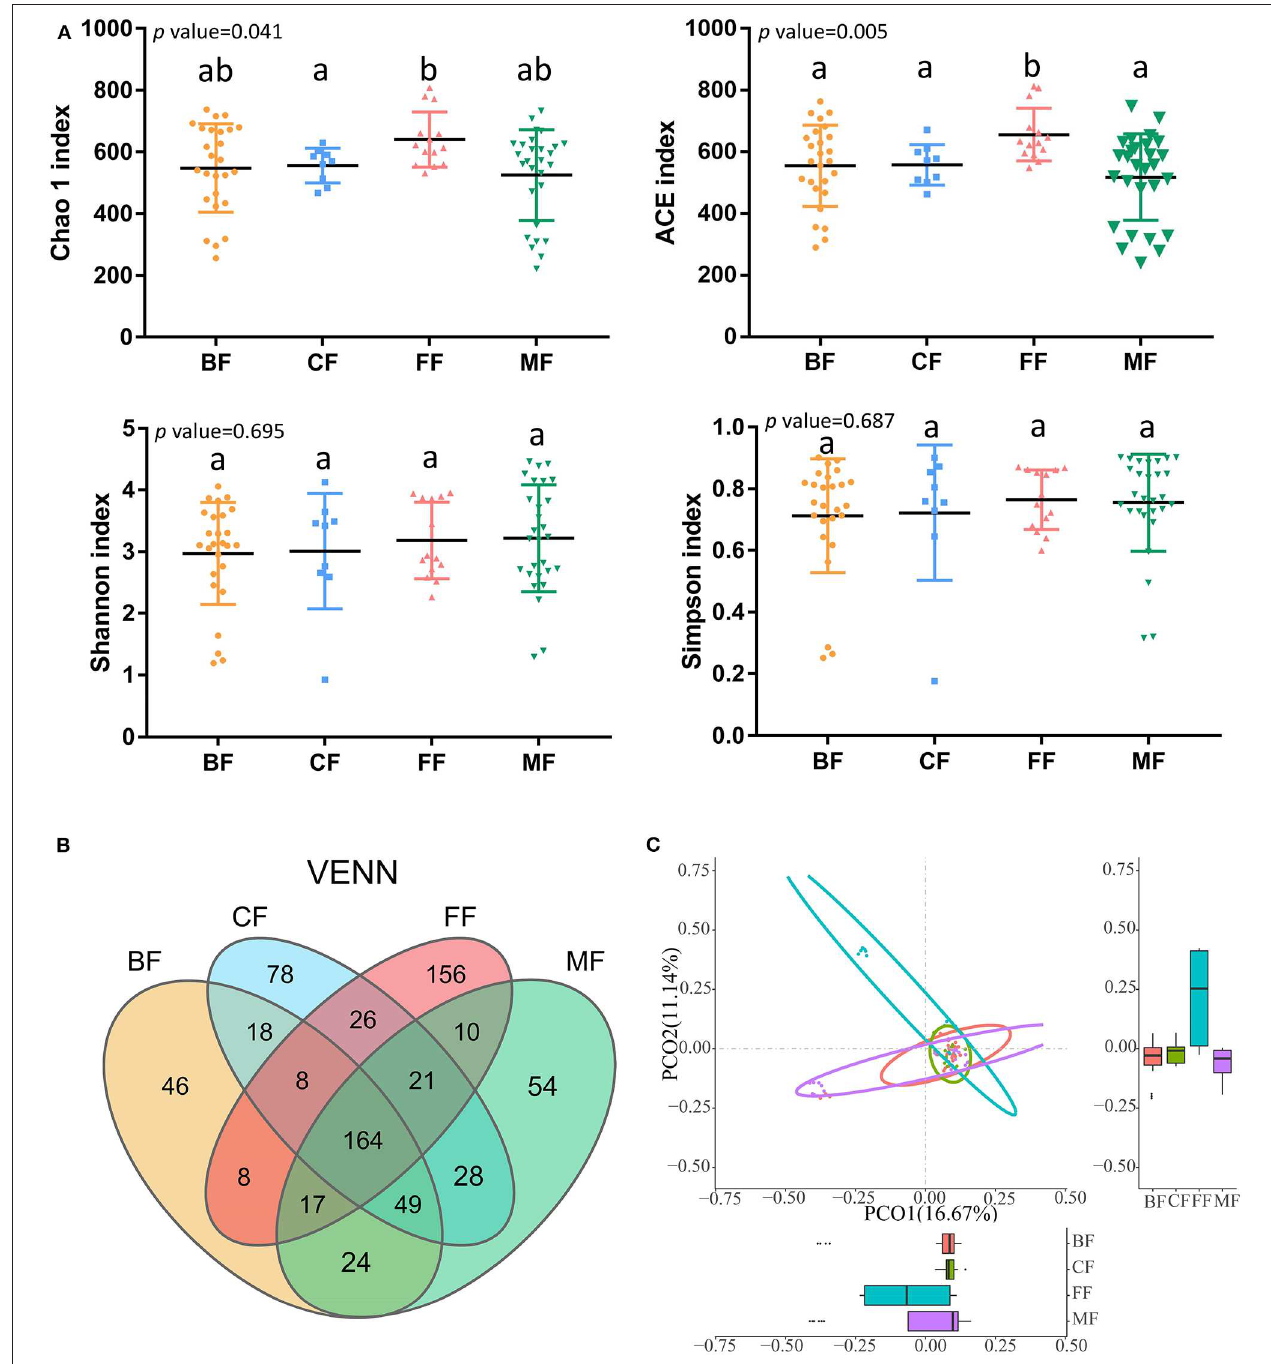
FIGURE 1 | Microbial community structure of infant stool in various feeding methods. (A) Alpha diversity in groups. (B) Venn diagram of operational taxonomic units (OTUs) among the four groups. (C) Principal coordinate analysis (PCoA) on unweighted UniFrac distances in groups; p < 0.001, R 2 =